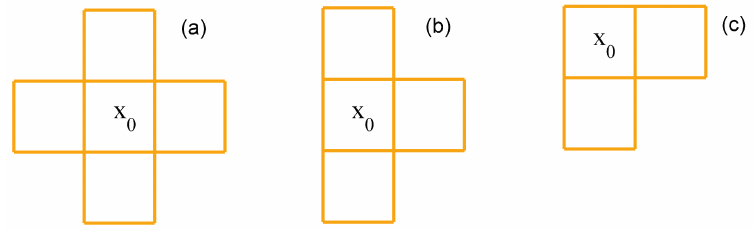
Figure 2. Three situations in Laplacian smoothing. ( a ) x 0 lies in the central part; ( b ) x 0 lies on the boundary but not in the corner; ( c ) x 0 lies in the